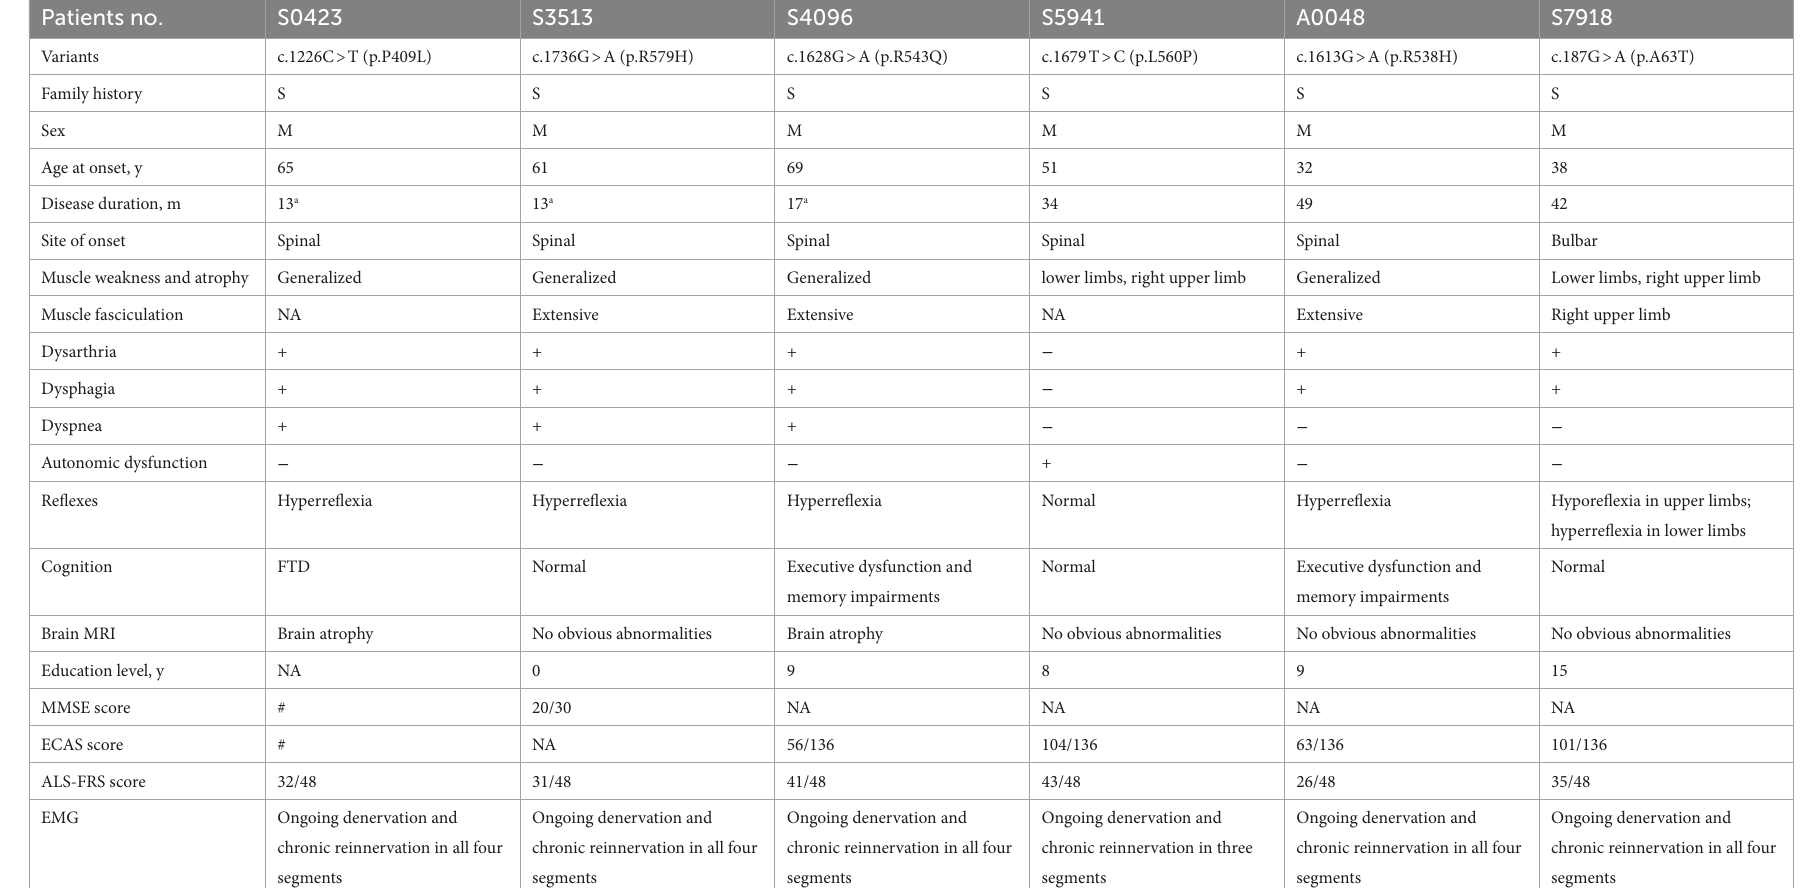
TABLE 1 Clinical features of patients with ALS with rare, putative pathogenic variants in the TP73 gene. Patients